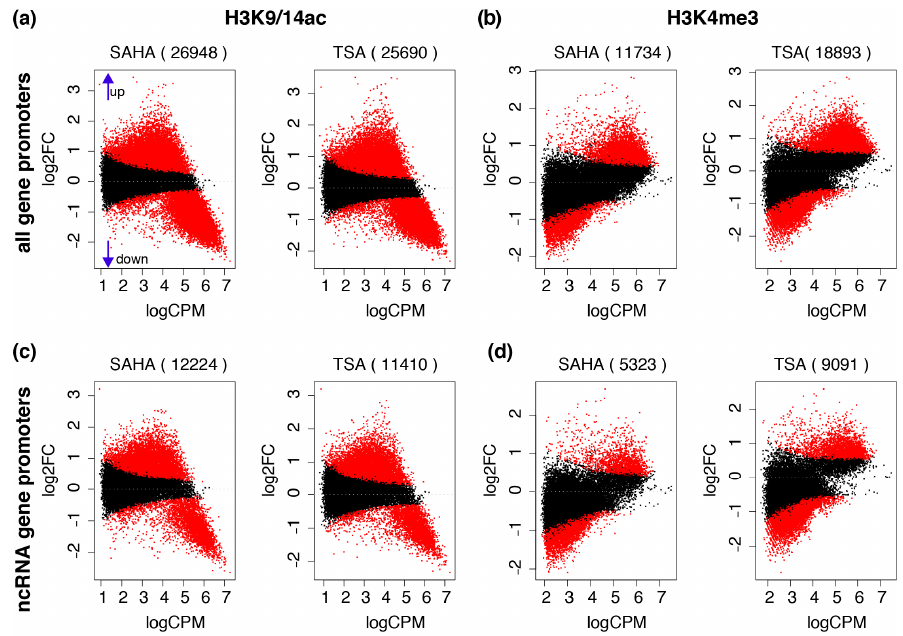
Figure 2. Dynamic histone acetylation changes at the ncRNA promoters by HDAC inhibition. Mean-Average (MA) plots show the fold changes (logFC, log2 of the fold change) and the relative read concentration (logCPM) for histone acetylation (H3K9/14ac) at ( a ) all genes and ( b ) ncRNA gene promoters, as well as histone methylation at ( c ) all genes and ( d ) ncRNA gene promoters. Red points indicates FDR p value < 0.05, and black indicates FDR p value > 0.05. The number of genes FDR < 0.05 is shown in parenthesis on top of each